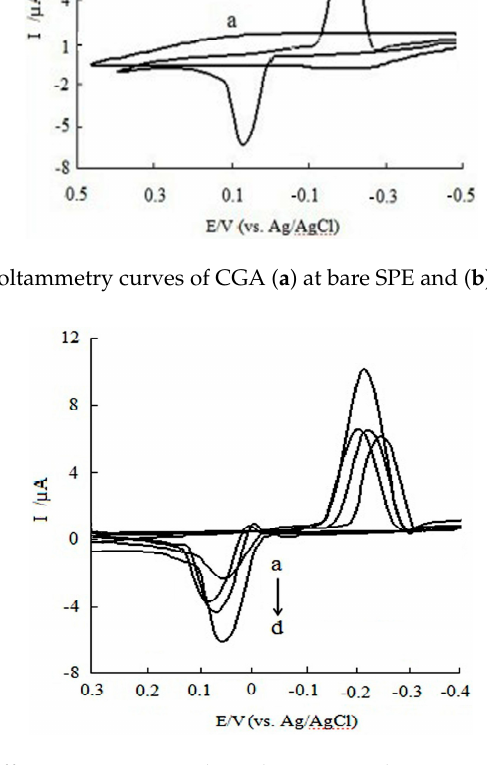
Figure 5. Influence of different supporting electrolytes on peak current: ( a ) 0.10 mol/L potassium hydrogen phosphate-potassium dihydrogen phosphate buffer; ( b ) 0.10 mol/L phosphate buffer solutions; ( c ) 0.10 mol/L citric acid buffer; ( d ) 0.10 mol/L acetic acid-sodium acetate buffer.